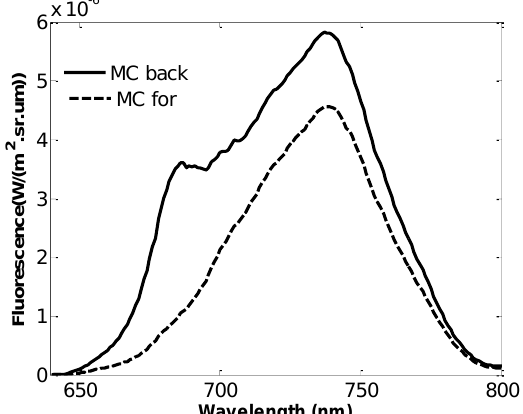
Figure 3. Simulated leaf backward (MC back) and forward (MC for) fluorescence by the MC model